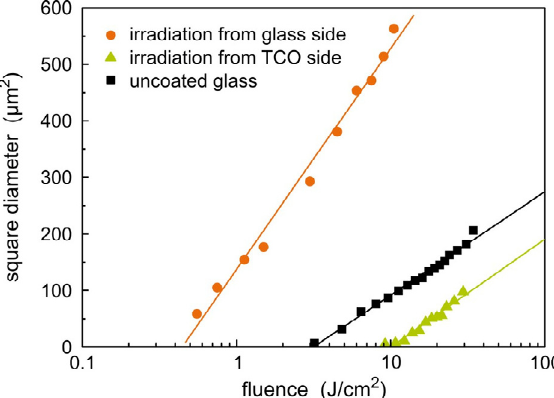
Fig. 5. Liu plot of squared diameters of ablation areas ob- tained by irradiation of TCO/glass samples from TCO (tri- angles) or glass side (circles), and of a pure glass substrate (squares) for